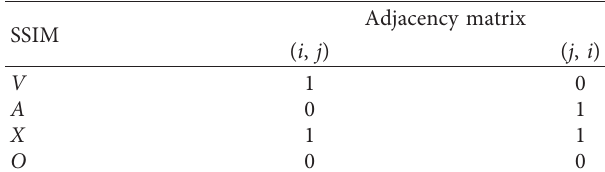
Table 4: Substitution